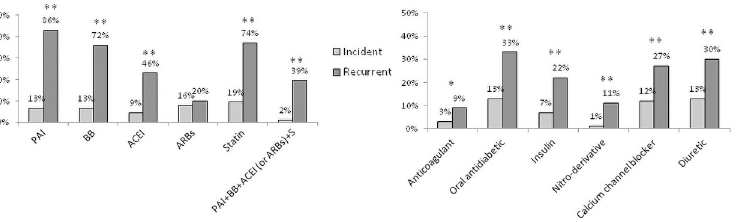
Fig 1. Drug treatments before hospital admission in patients with an incident or recurrent acute coronary syndrome. � p < 0.001, �� p < 0.0001, after adjustment for sex and age. PAI: Platelet aggregation inhibitor; BB: Beta- blocker; ACEI: Angiotensin-converting-enzyme inhibitor; ARBs: Angiotensin receptor blockers; S: Statin.